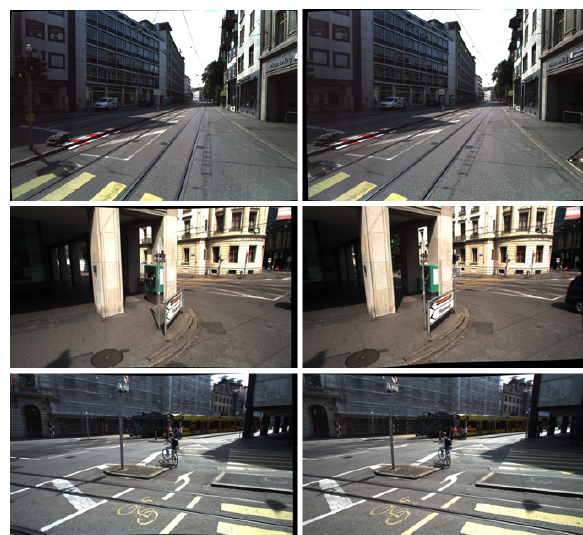
Figure 4. Forward stereo (top), back-right stereo (middle) and left stereo images (bottom) captured at the same location (see Figure 3) during the campaign in Basel in July 2014